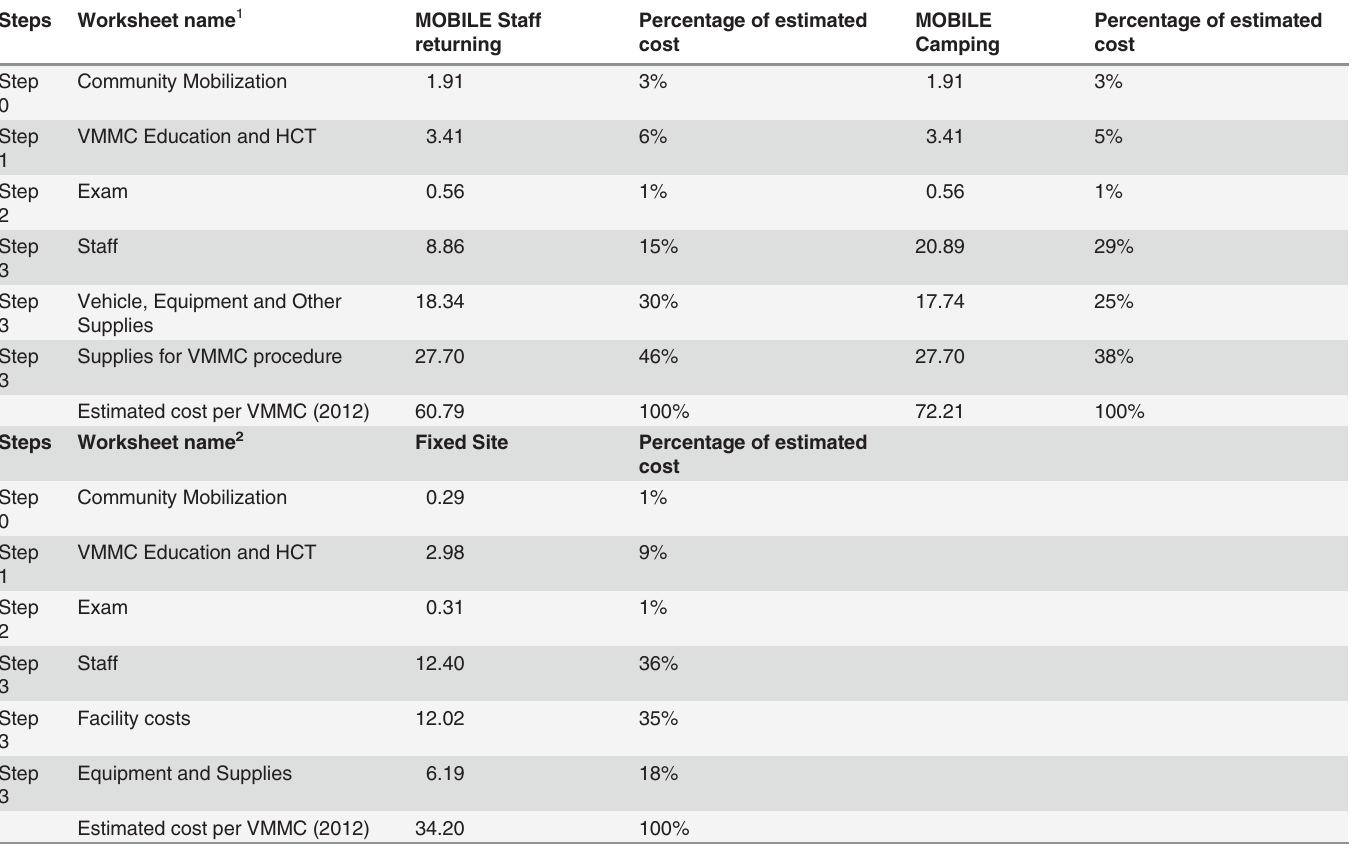
Table 2. Estimated cost per VMMC for 2012 program conditions